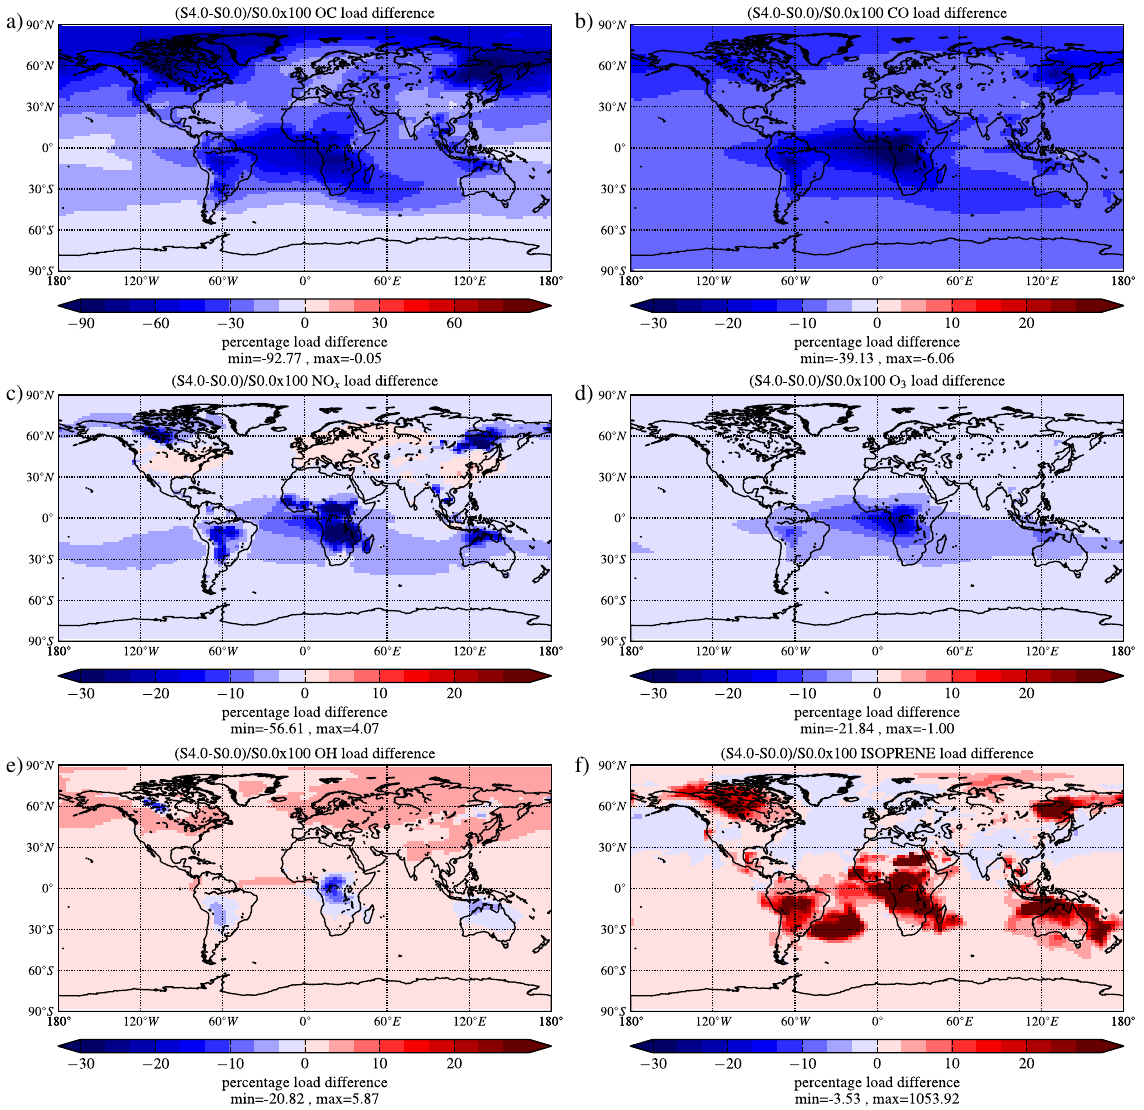
Figure 7. Percentage difference in the computed annual mean tropospheric loads of OC (a) , CO (b) , NO x (c) , O 3 (d) , OH (e) , and isoprene (f) – attributed to wildfire emissions calculated as (column_S4.0 – column_S0.0) / (column S0.0) × 100. The scale is from − 30 to 30% ( − 90 to 90% for OC); the minimum and maximum differences are printed below each